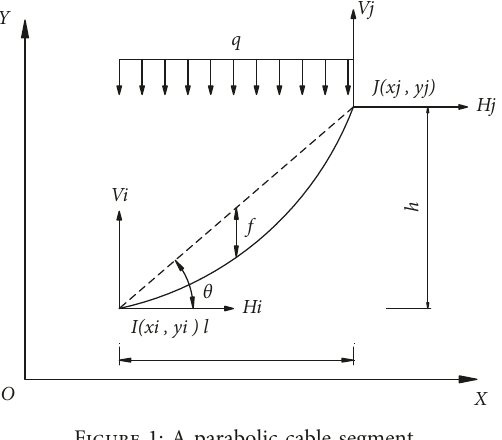
Figure 1: A parabolic cable